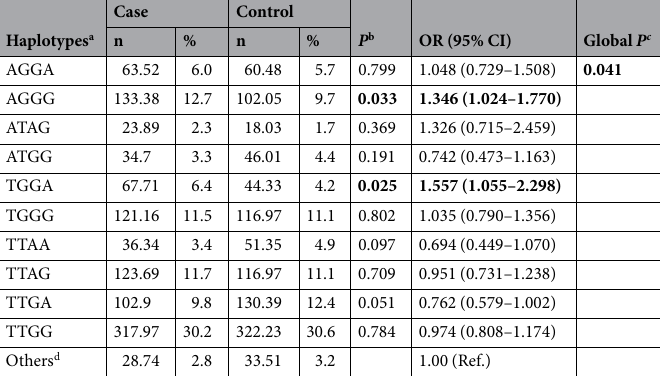
Table 5. Frequencies of inferred haplotypes among the cases and controls and their association with risk of NIHL. a The alleles of haplotypes were arrayed as rs7578578-rs749131-rs1550117-rs2228611. b Two-sided χ 2 test. c Generated by permutation test with 1000 times of simulation. d Haplotypes with a frequency < 0.02 (AGAA/ AGAG/ATAA/ATGA/ATGG/TGAA/TGAG) were pooled into the mixed